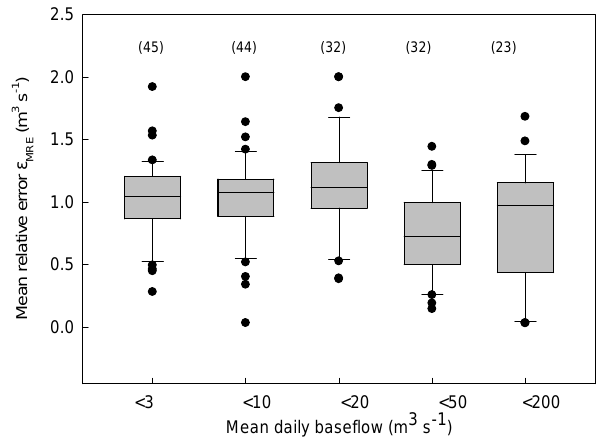
Fig. 3. Distribution of the mean relative error for different mean daily baseflow ranges. The number in brackets is the sample size per range.